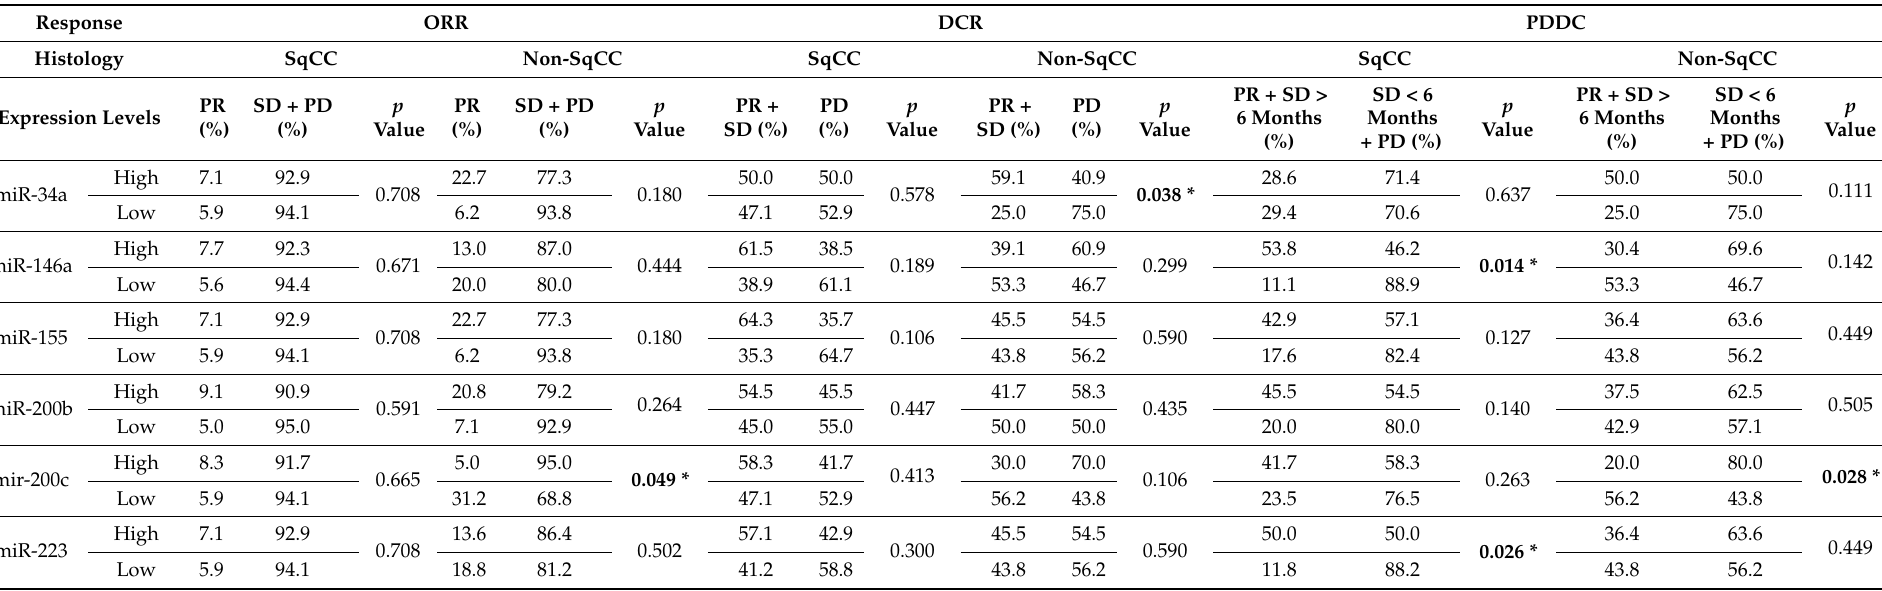
Table 2. MiRNAs Correlation and Response to